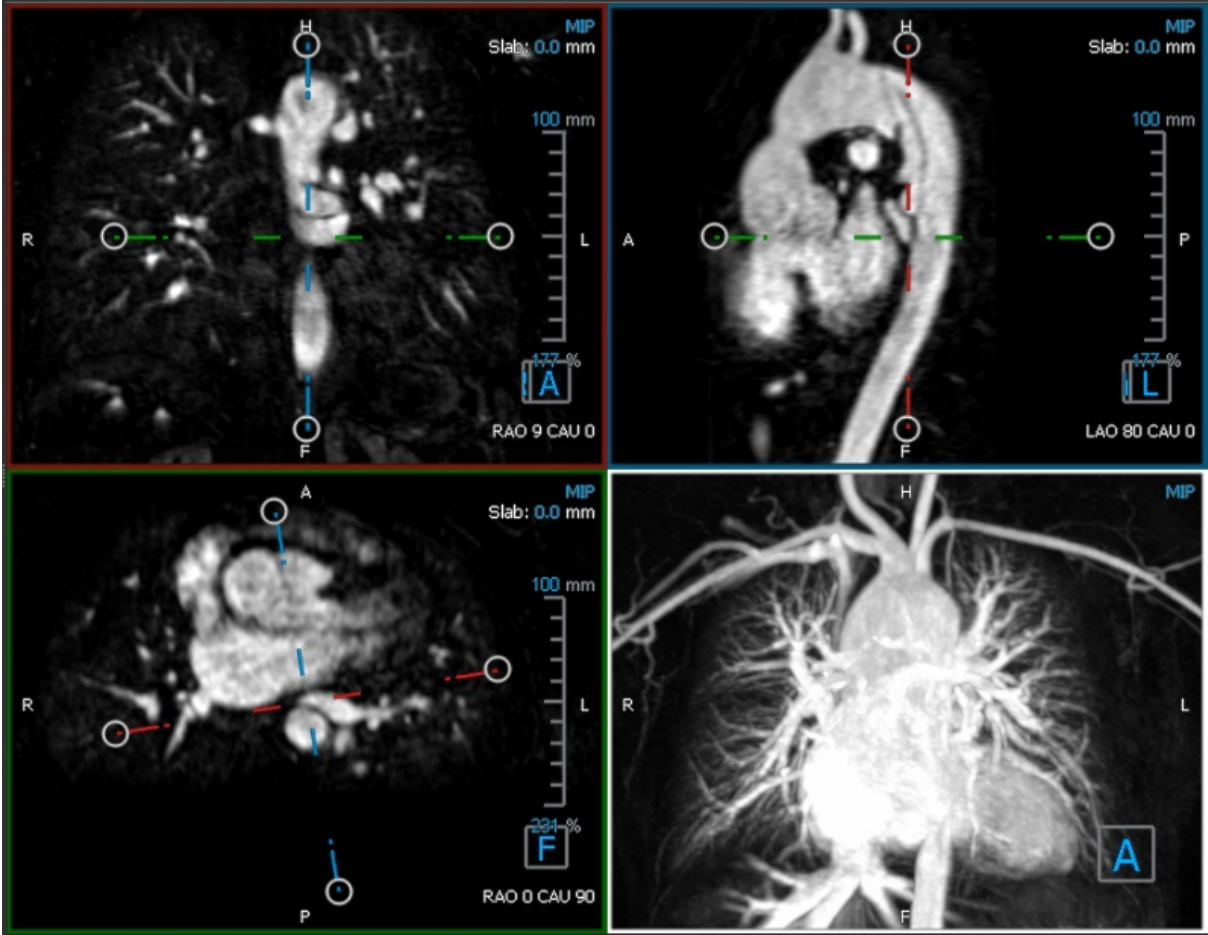
Figure 3. 2D cross-sectional images of the repaired coarctation of